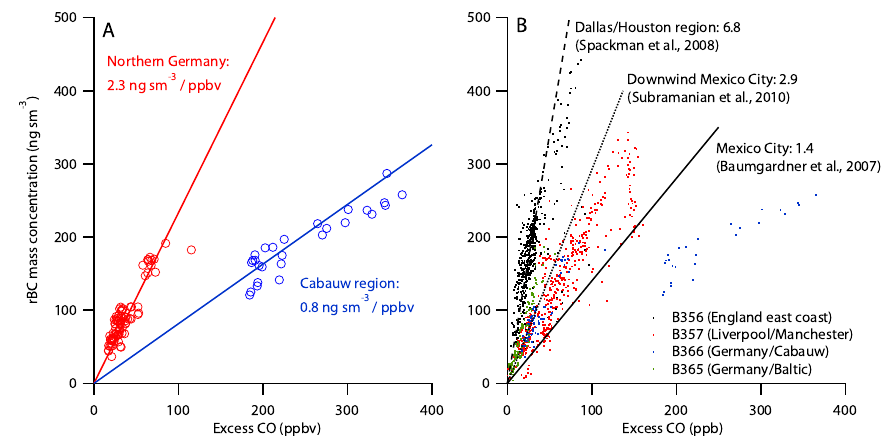
Fig. 8. Refractory black carbon mass concentrations (ngsm − 3 ) plotted against excess carbon monoxide mixing ratios (ppbv) for (a) 8 May 2008 (B366) and (b) B366 and three additional flights. Each data point represents a 20–30s average, depending on the AMS time resolution. Solid coloured lines in (a) give the linear regression (forced through the origin) of rBC onto excess CO. The dashed line in (b) shows the regression coefficient provided by Spackman et al. (2008) for aircraft-based measurements in urban and industrial outflow near Dallas and Houston, Texas, USA, adjusted to the same units as our data and for the 1.1 scaling factor applied to the Spackman et al. (2008) data. The solid and dotted lines show the regressions reported by Baumgardner et al. (2007) and Subramanian et al. (2010) for ground- and aircraft-based SP2 observations in and downwind of Mexico